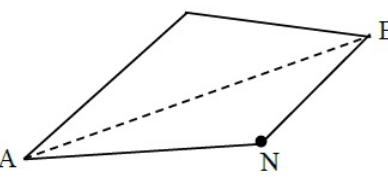
Figure 14: New point appears outside.